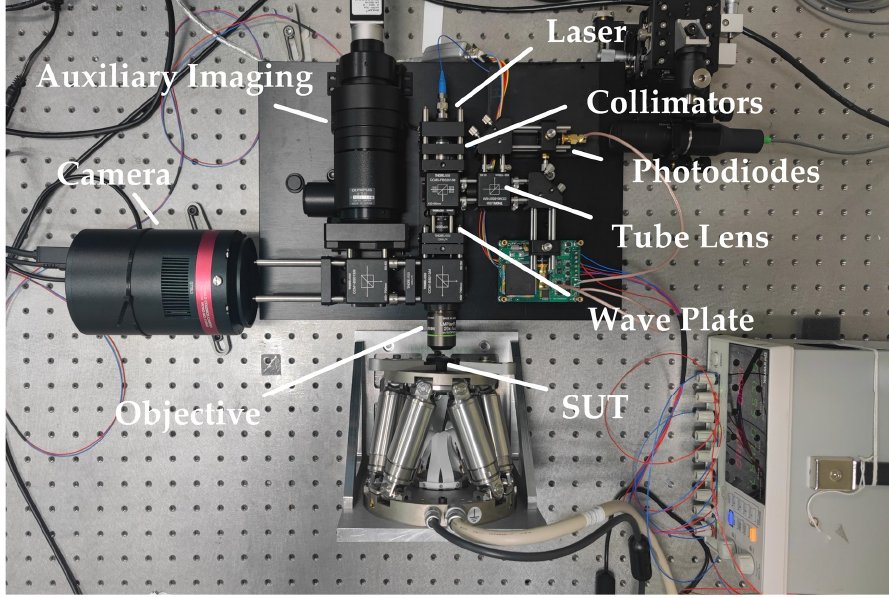
Figure 7. Experimental setup for the measurement system proposed in this